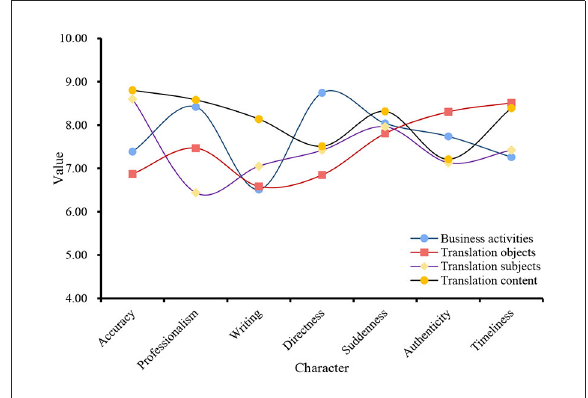
FIGURE3 Features of business English